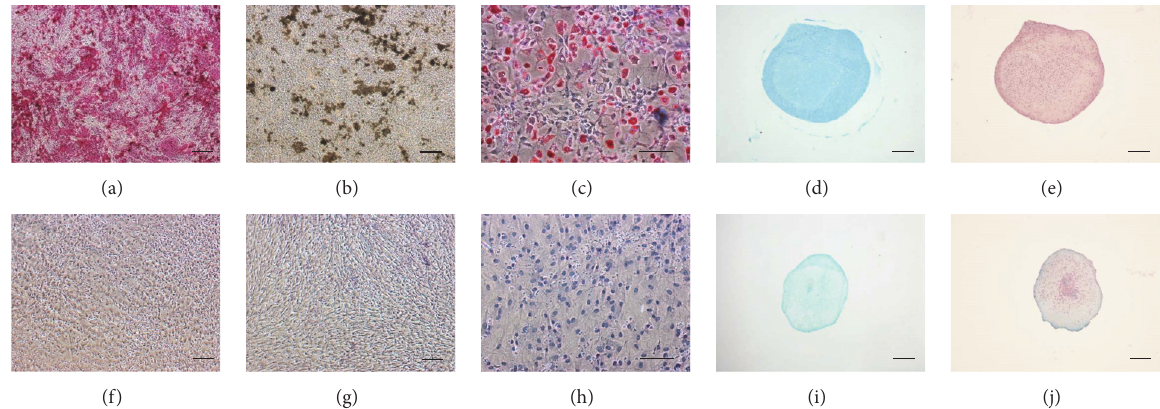
Figure2:TrilineagedifferentiationpotentialofcaninecranialcruciateLDSCs.ImagesareshownforLDSCsafterinductionofosteogenic,adi- pogenic, and chondrogenic differentiation after appropriate staining (a)–(e). Cells subjected to osteogenic differentiation media were stained for both calcium deposits using alizarin red stain (a) and alkaline phosphatase activity (b). Cells subjected to adipogenic differentiation media were stained for oil droplet formation using oil red O (c), and cell pellets exposed to chondrogenic differentiation media, for GAG formation using alcian blue (d) and safranin O (e). Negative control cells were incubated in control media and stained as above (f)–(j). Bars = 100 𝜇